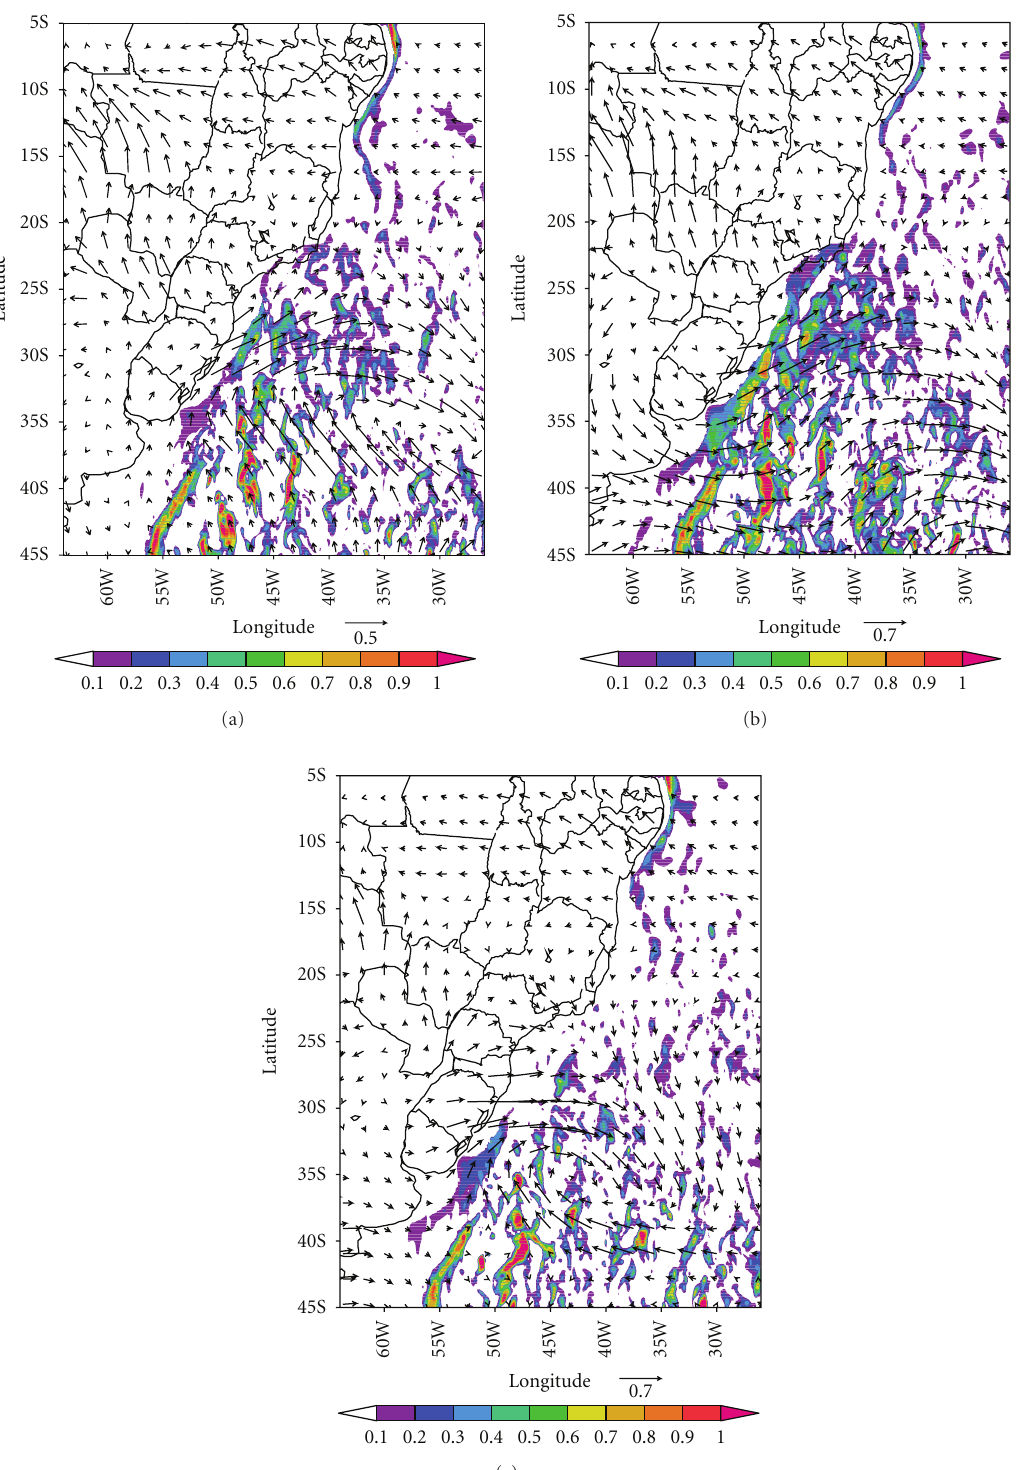
Figure 6: Snapshots for atmospheric momentum flux vectors from NCEP Reanalysis, and HYCOM northward meridional ocean currents (shaded) for (a) 10th, (b) 16th, and (c) 22nd of June